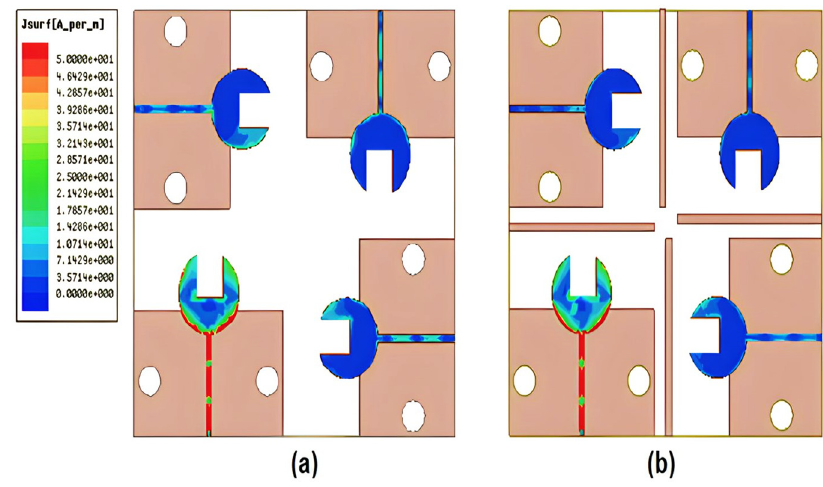
Figure 11. The fabricated prototype photo (Top/Back views) of the 4-port MIMO antenna.